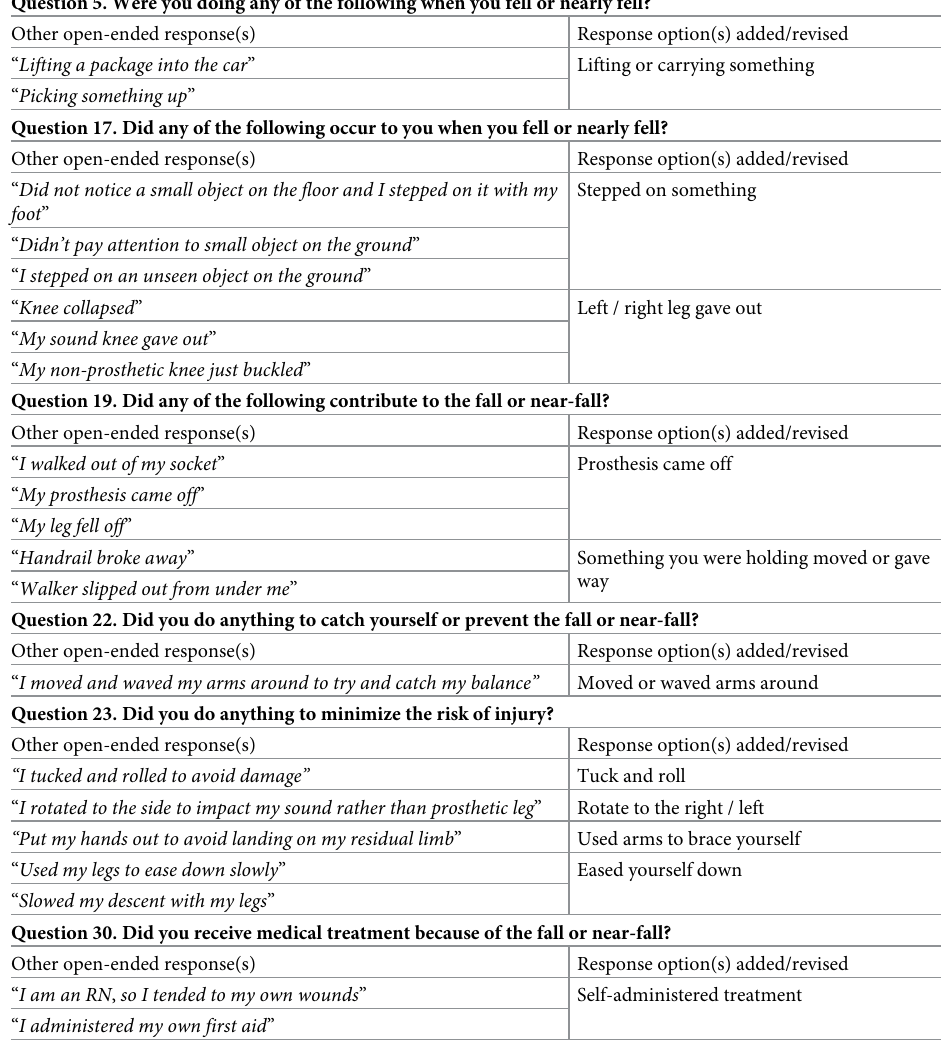
Table 5. Response options added to the fall survey based on open-ended “Other” field responses provided by study participants during the small-scale administration. Question 5. Were you doing any of the following when you fell or nearly